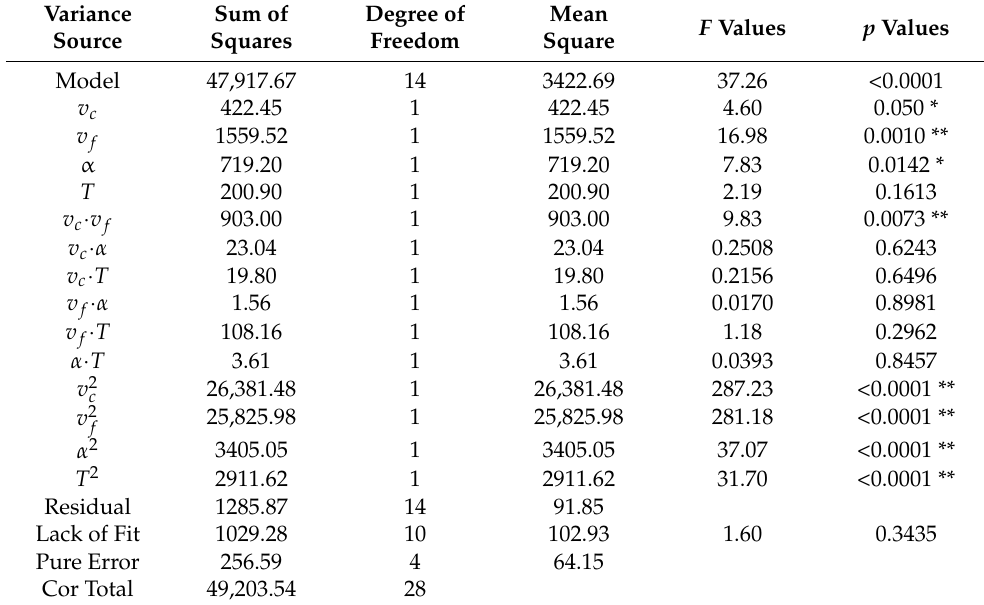
Table 4. Analysis of variance for sawing power